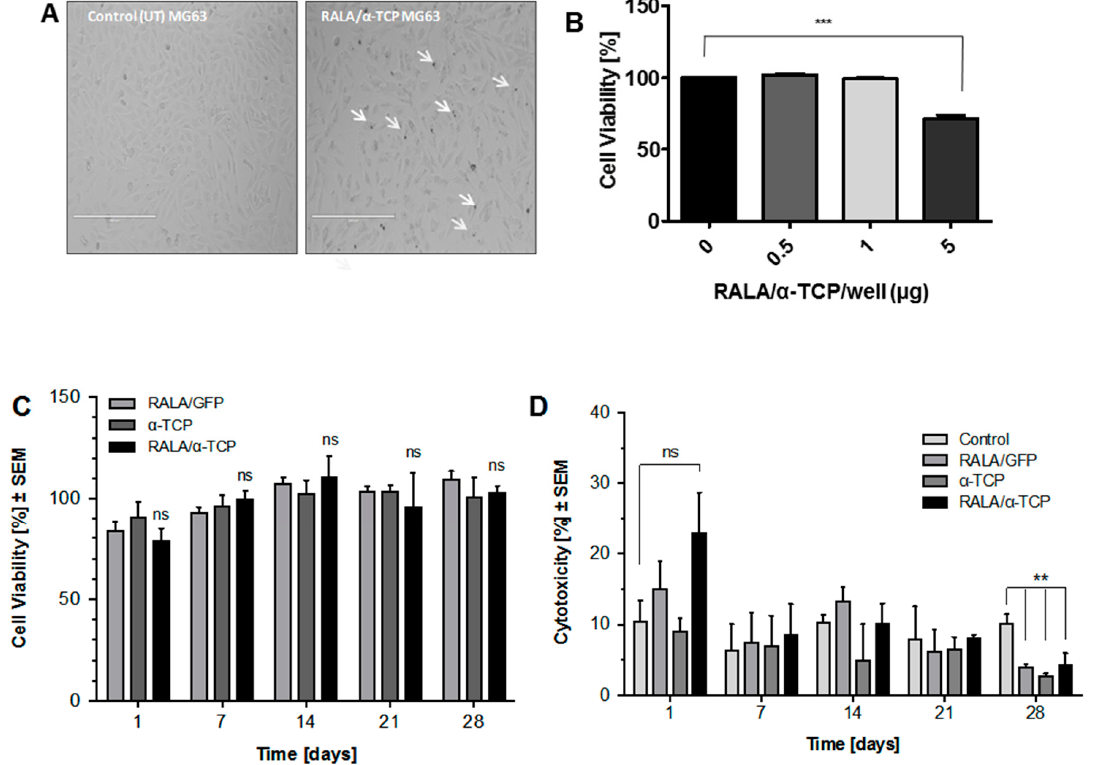
Figure 4. In vitro characterization of RALA / α -TCP transfection and cytotoxicity. ( A ) representative phase contrast images of MG-63 osteoblast-like cells 24 h after transfection with 1 µ g RALA / α -TCP NPs at formulation mass ratio 5. White arrows indicate NP deposits. (Scale bar = 400 µ m). ( B ) percentage cell viability of MG-63 cells when transfected with varying concentrations of RALA / α -TCP NPs (mass ratio 5); equivalent to 0.5, 1 and 5 g α -TCP / well of 96-well plate. ( C ) and ( D ) percentage cell viability of MG-63 cells over 28 d period after transfection with RALA / α -TCP NPs (equivalent of 1 µ g α -TCP / well (96-well plate), mass ratio 5) assessed by ( C ) CellTiter 96 ® Aqueous One Solution Cell Proliferation Assay (MTS) assay and ( D ) lactate dehydrogenase (LDH) assay. (N = 3 ± SEM). ns = not significant p > 0.05, ** = p < 0.01, *** = p < 0.001.